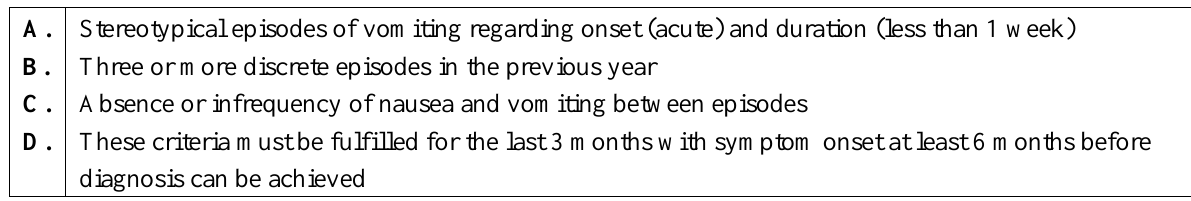
Table 1. Rome III criteria